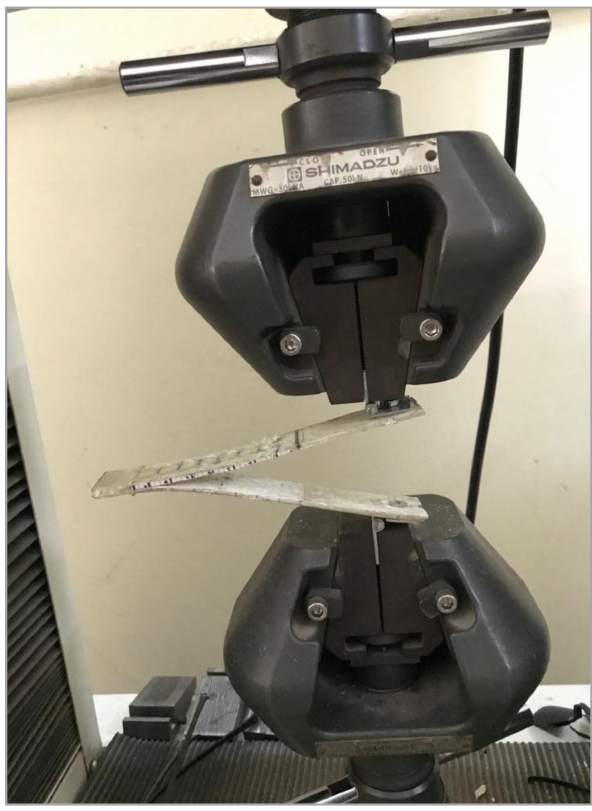
Figure 3. DCB specimen gripped in